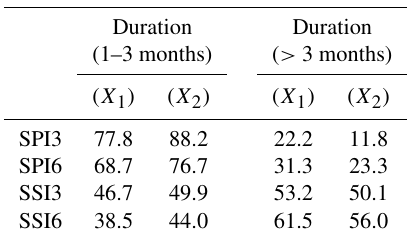
Table 2. Frequency of droughts for different durations, expressed as a percentage of the total drought events in core crop region, from in- dices of SPIs and SSIs. Droughts were detected using the thresholds X 1 (one-half standard deviation) and X 2 (one standard deviation) from January 1979 to December 2018. The duration of the events was grouped into short-term (1–3 months) and long-term droughts ( > 3